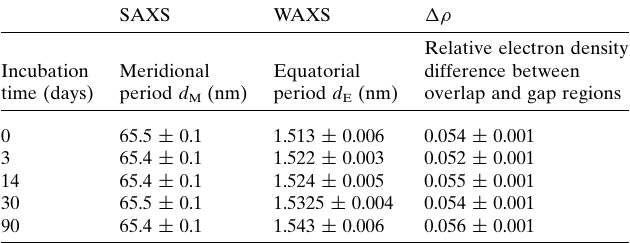
Table 2 SAXS/WAXS parameters measured on collagen in a 40 mg ml (cid:2) 1 glucose solution.